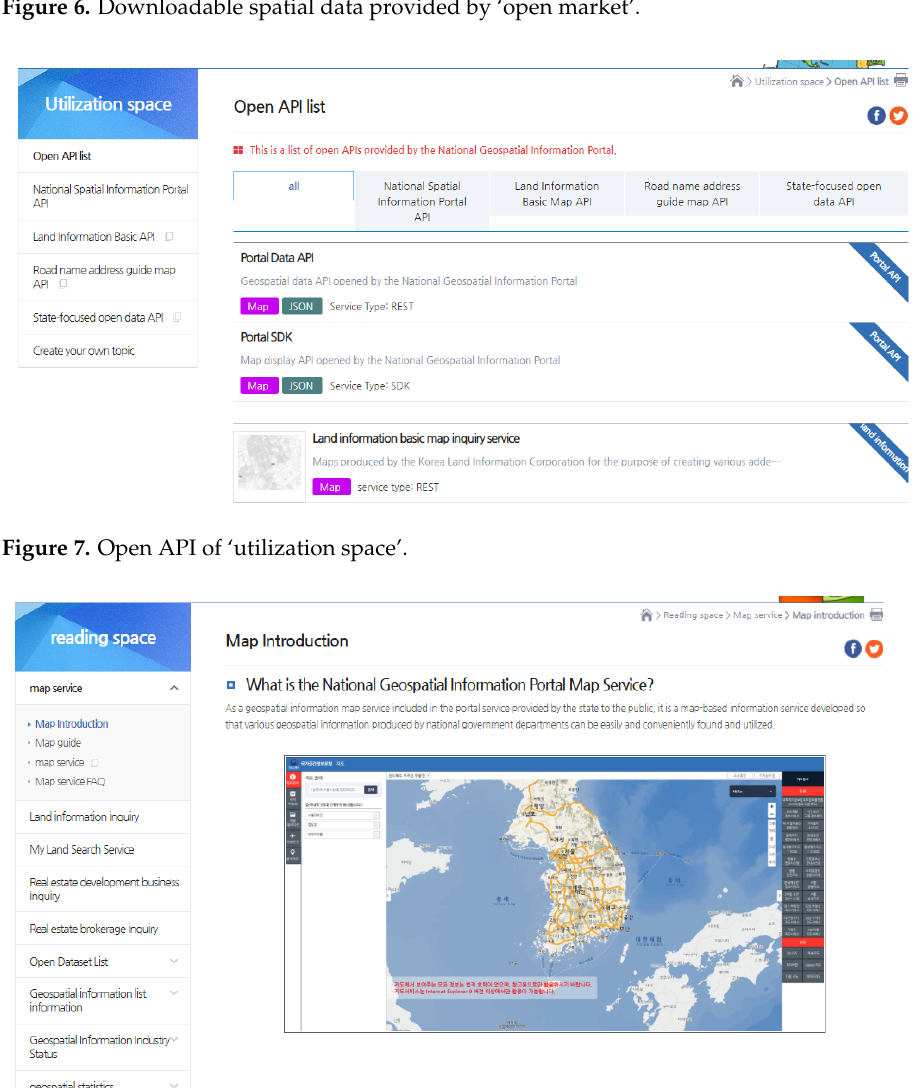
Figure 6. Downloadable spatial data provided by ‘open market’.